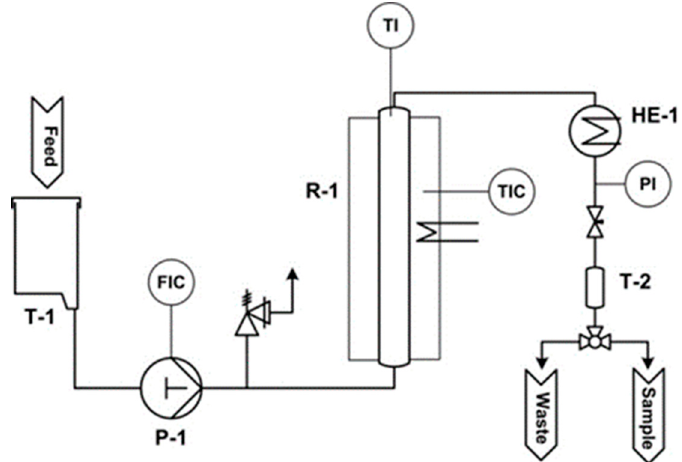
Figure 1. Piping and instrumentationdiagram of test rig. T-1: feedstock tank, P-1: pump, R-1: tubular reactor with surrounding heating block, HE-1: cooler, T-2: small tank.